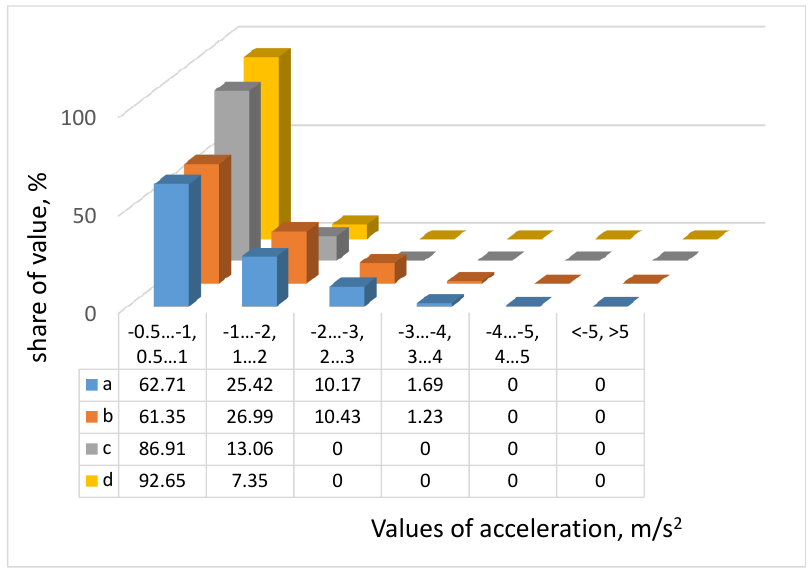
Figure 10. Distributions of absolute values of the extreme of lateral acceleration during turning ma- neuvers for various route sections: (a) city road; (b) suburban road; (c) expressway (dual carriageway); (d) highway.